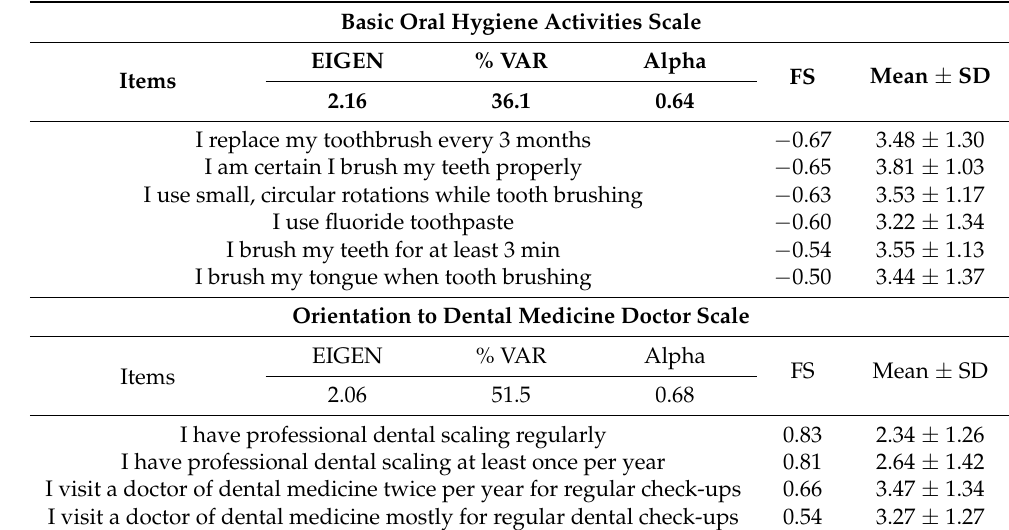
Table 2. Oral Health Activities Questionnaire